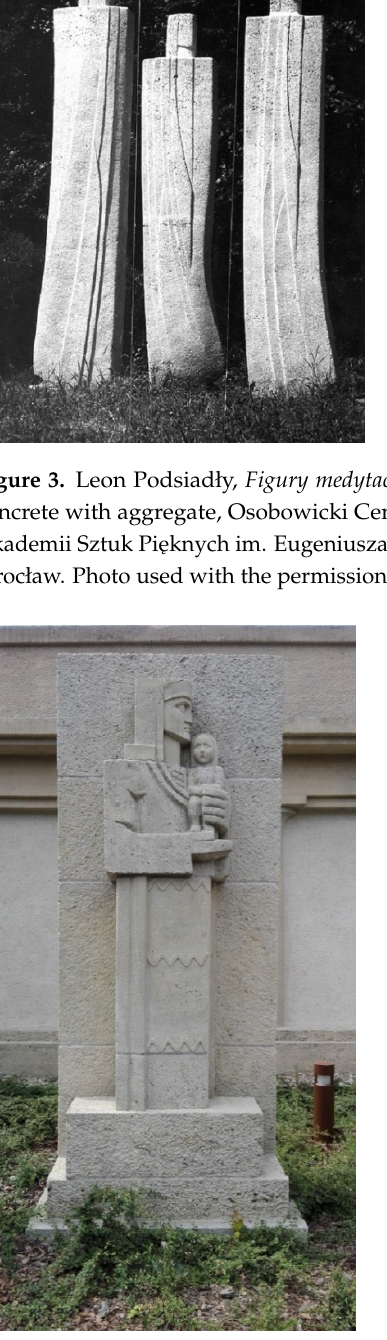
Figure 4. Xawery Dunikowski, Kobieta śląska [ Silesian Woman ], 1949, granite, pillar decorating sculpture, part of Memorial to the Silesian Uprising (1946–1955), Saint Anne Mountain. Photograph by Karolina